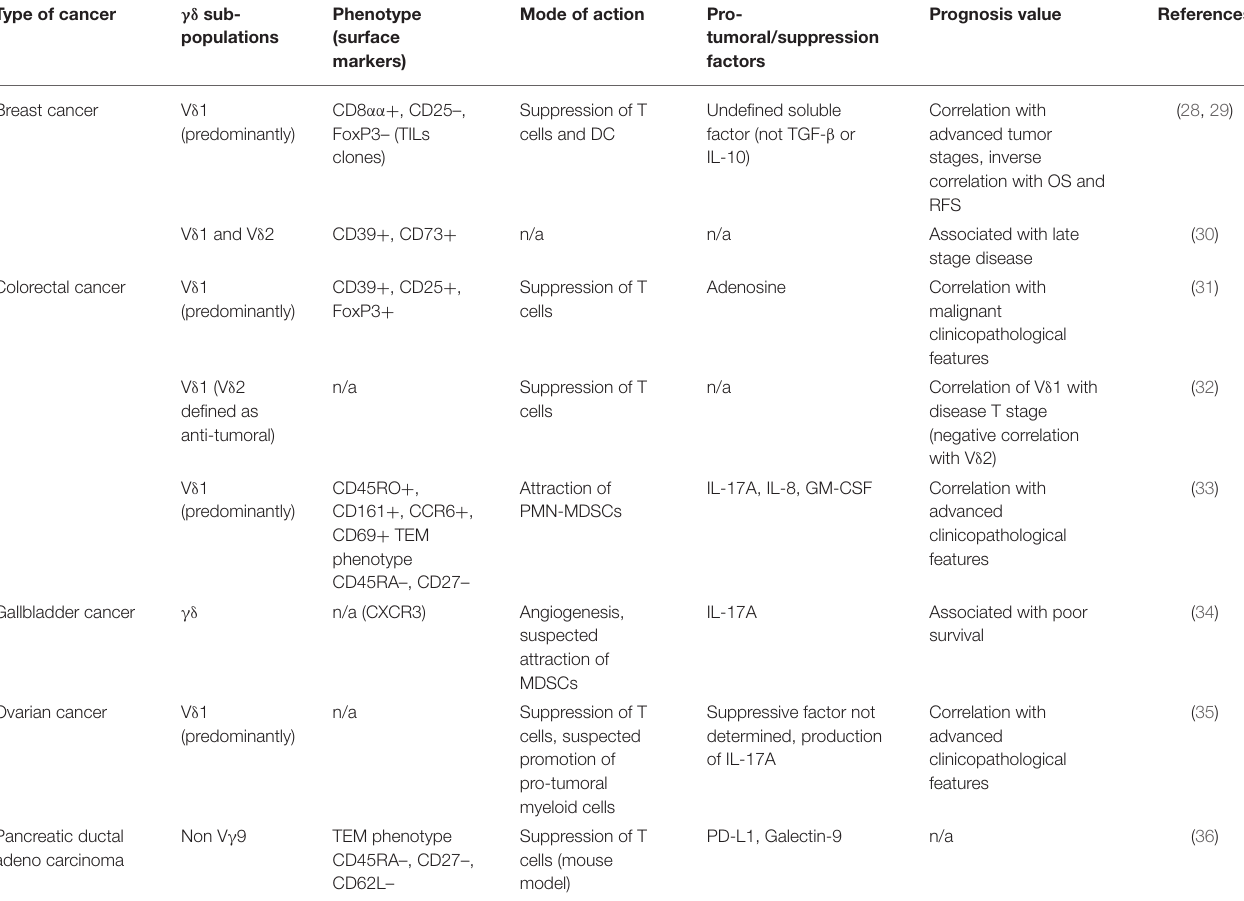
TABLE 1 | Pro-tumoral characteristics of infiltrating γδ T cells in human